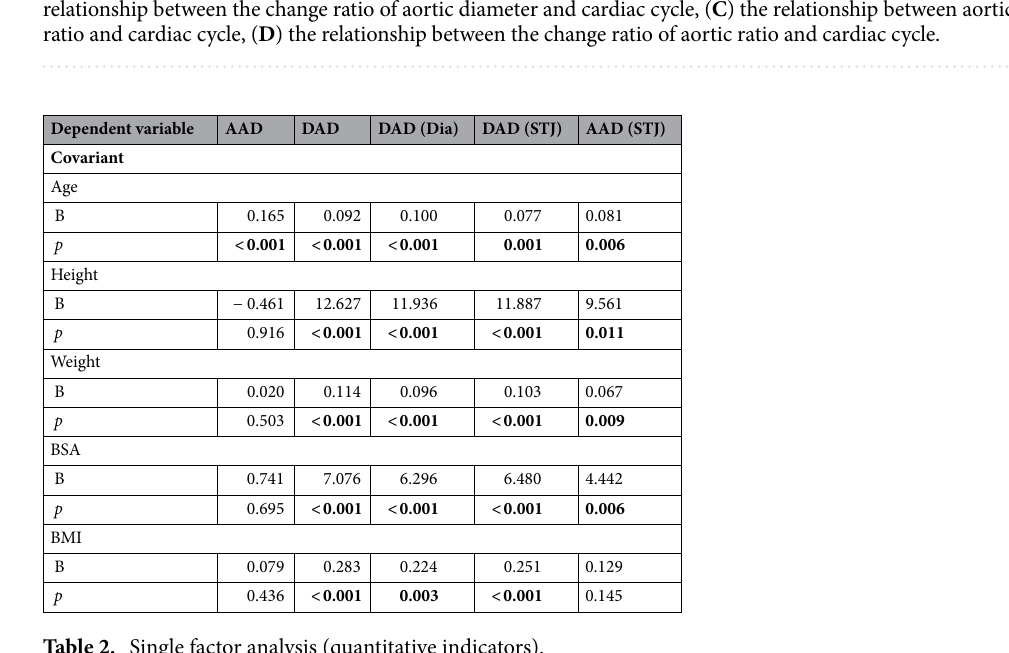
Table 2. Single factor analysis (quantitative